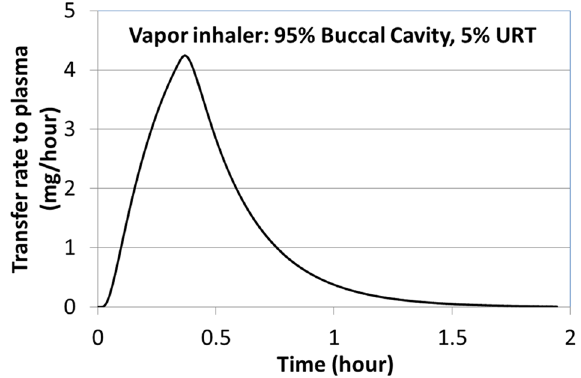
Figure 8. Rate of nicotine transfer to blood from using vapor inhaler with 95% BC absorption and 5% in URT calculated from permeation model based on the diffusion Eq. (3).